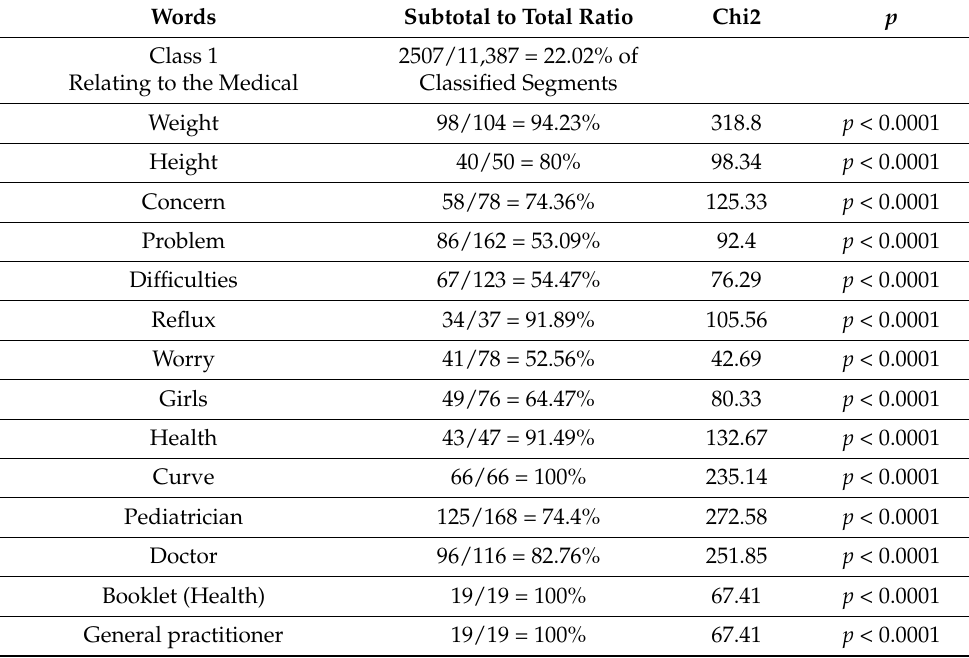
Table A2. Classes, ratio, Chi2 and p for parents: first associated